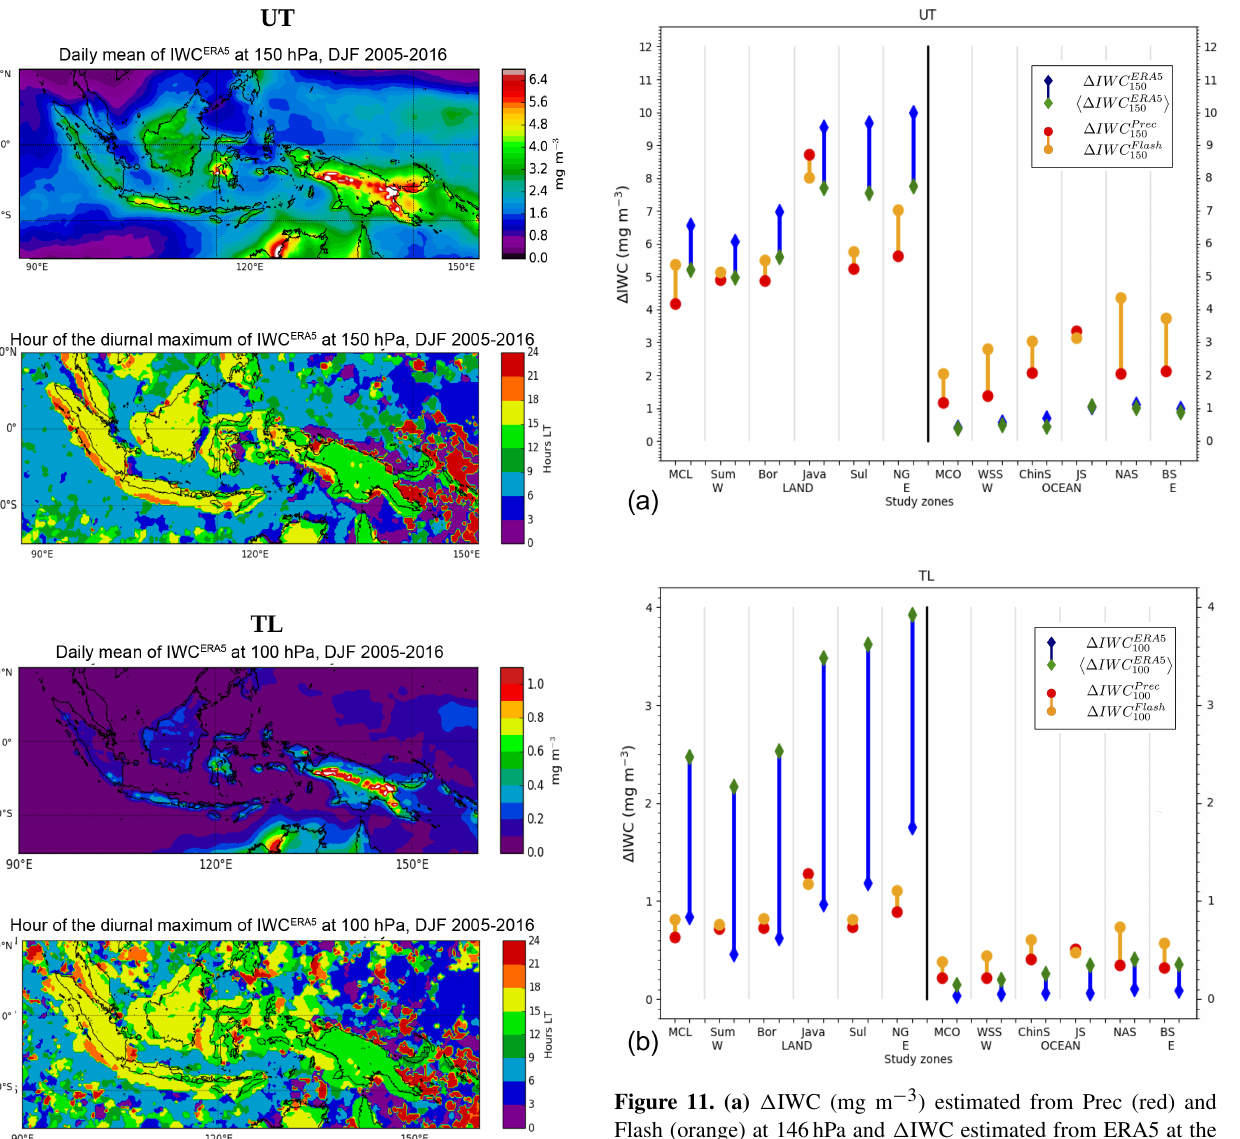
Figure 10. Daily mean of IWC ERA5 averaged over the period DJF 2005–2016 at 150hPa (a) and at 100hPa (c) . Time (hour, local time (LT)) of the diurnal maximum of IWC ERA5 at 150hPa (b) and at 100hPa (d) .